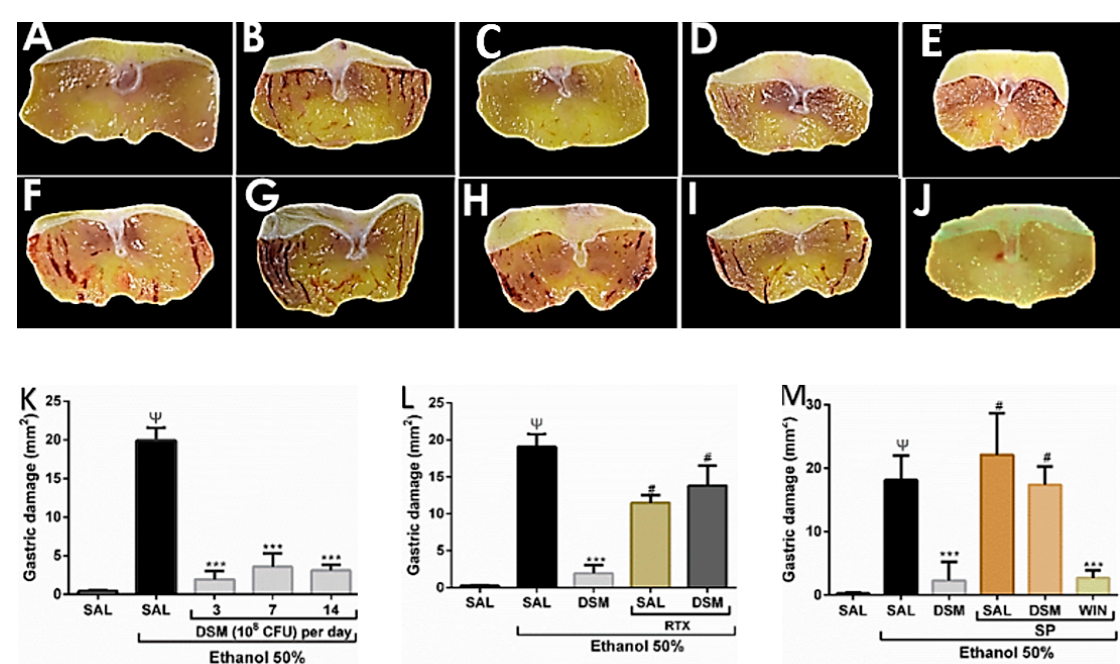
Figure 1. Lactobacillus reuteri DSM 17938 (DSM) supplementation on ethanol-induced gastric damage and the role of the TRPV1/substance P (SP) axis. ( A ): Healthy group (saline). ( B ): Injured group (50% ethanol). ( C – E ): Mice pretreated with 10 8 CFU/g • bw/day DSM for 3 ( C ), 7 ( D ), and 14 days ( E ), followed by ethanol administration. ( F ): Mice treated with Resiniferatoxin (RTX, 3 nmol/kg p.o.) and 50% ethanol. ( G ): DSM Pretreatment (3 days) in combination with RTX and ethanol treatment. ( H ): Mice treated with 1 µ mol/L per 20 g i.p. (SP) coadministered with 50% ethanol. ( I ): DSM supplementation in combination with SP and ethanol treatment. ( J ): Pretreatment with WIN-62577, an NK1 antagonist, in combination with SP and ethanol. ( K ): Macroscopic analysis of the gastric injuries upon treatment with ethanol alone and upon pretreatment with DSM. ( L ): Effects of treatment with RTX and ethanol (50%) in mice pretreated with DSM. ( M ): Effects of DSM supplementation on gastric damage induced by the combination of SP and ethanol treatment. The results are the mean ± S.E.M. of at least 5 mice per group. Results were analyzed using one-way analysis of variance (ANOVA) followed by a Newman–Keuls post hoc test. Ψ p < 0.0001 versus healthy group; *** p < 0.0001 versus injured group; # p < 0.0001